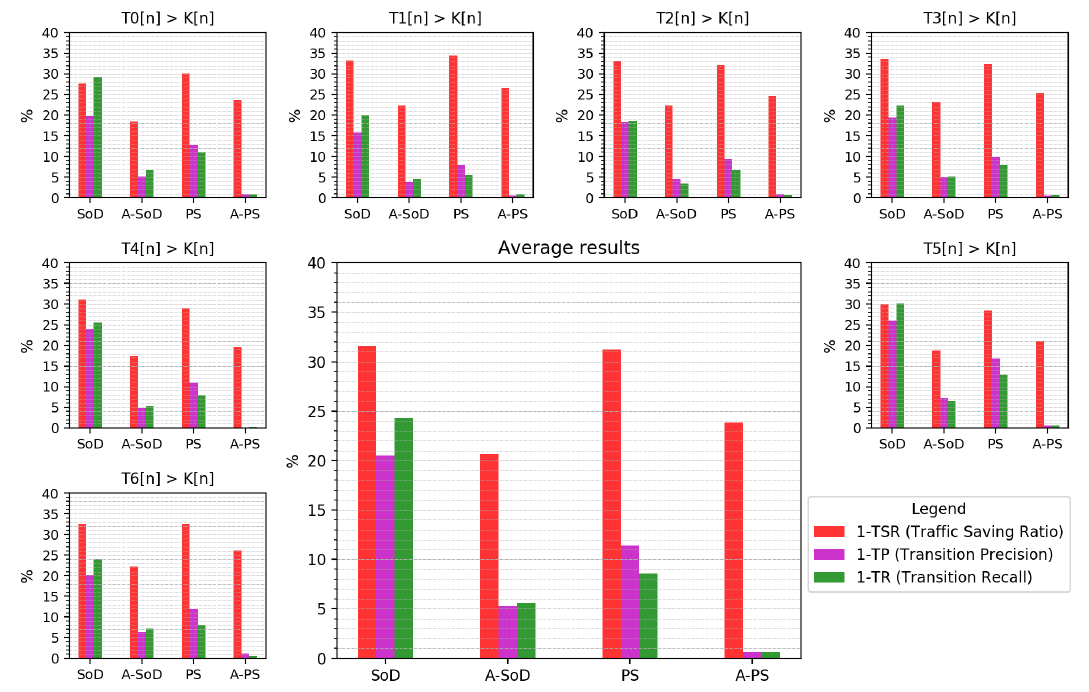
Figure 8. Case study III. With event-based sampling techniques SoD, PS, A-SoD, and A-PS